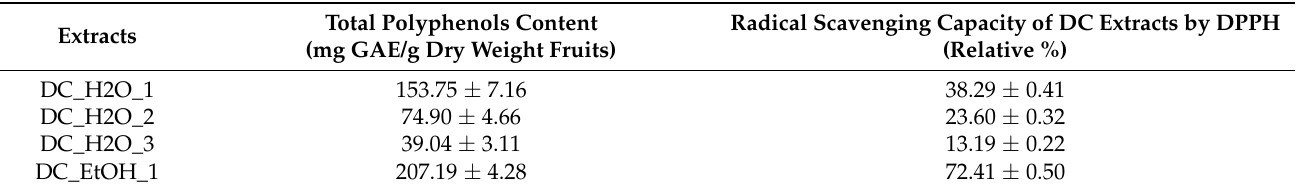
Table 1. Total polyphenols content and relative 2,2-diphenyl1-picrylhydrazyl (DPPH) radical scav- enging capacity of Dichrostachys cinerea fruits water and ethanolic